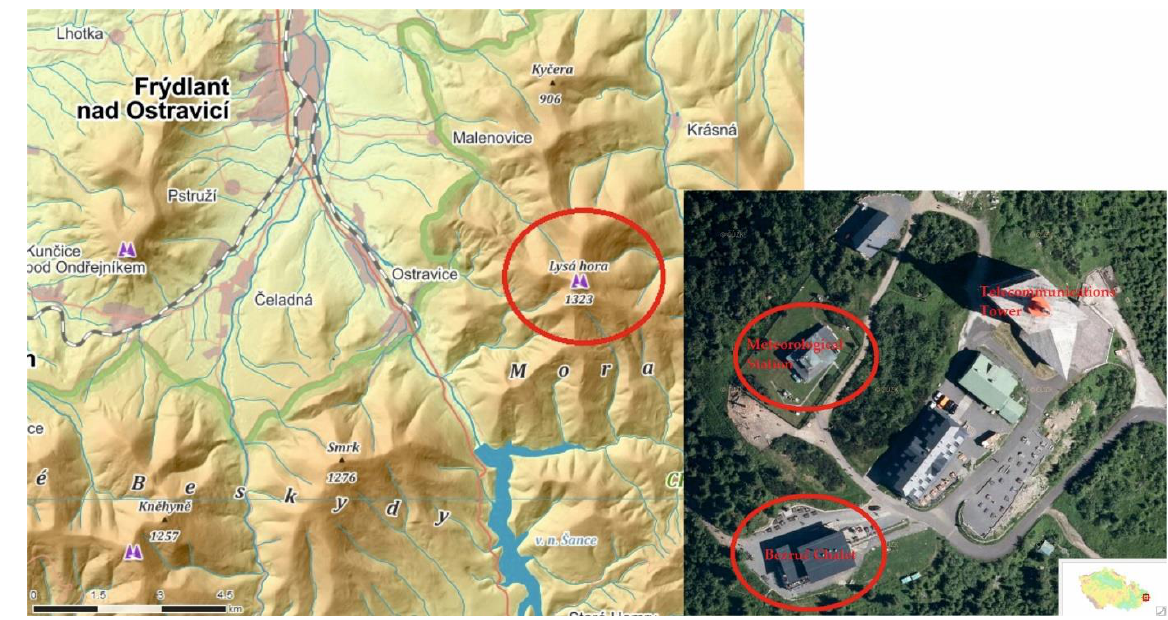
Figure 1. Position of Lysá hora and an aerial view at the top of the mountain [13].